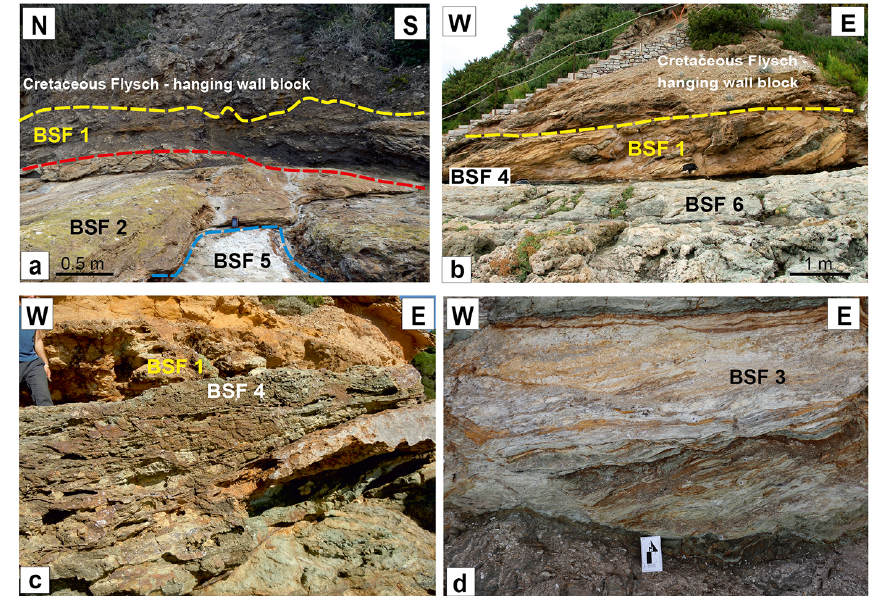
Figure 3. Field view of selected BSFs. Panels (a) and (b) show examples of the complex internal architecture of the ZF with the tight juxtaposition of several BSFs. (a) Northernmost exposed portion of the fault, allowing access to an almost complete section of the fault zone. There the ZF is composed of a stack of three different BSFs and the hanging wall block on top. (b) Sharp contact at Punta Zuccale between unit BSF 1 and BSF 6 separated by a thin layer of BSF 4. Note the mesoscale evidence of tectonic imbrication within BSF 1 indicating top-to-the-east transport. This is not obvious in (a) , as the view there is in the direction of transport. (c) Detail of BSF 1 (above) to BSF 4 (below) contact. (d) Pervasively foliated phyllonitic BSF